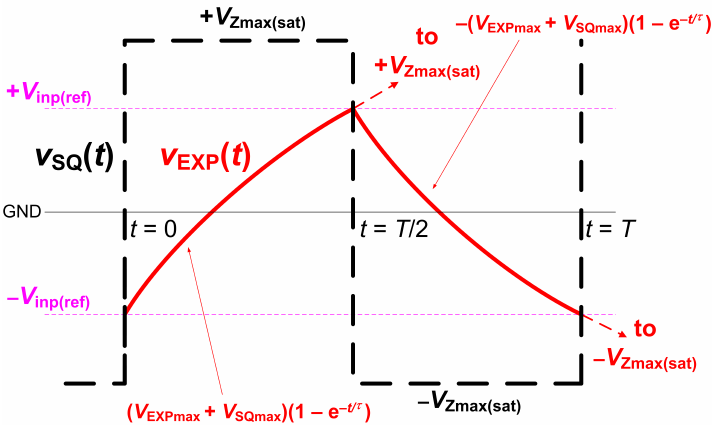
Figure 4. Time diagram of transient responses for analysis of the generator